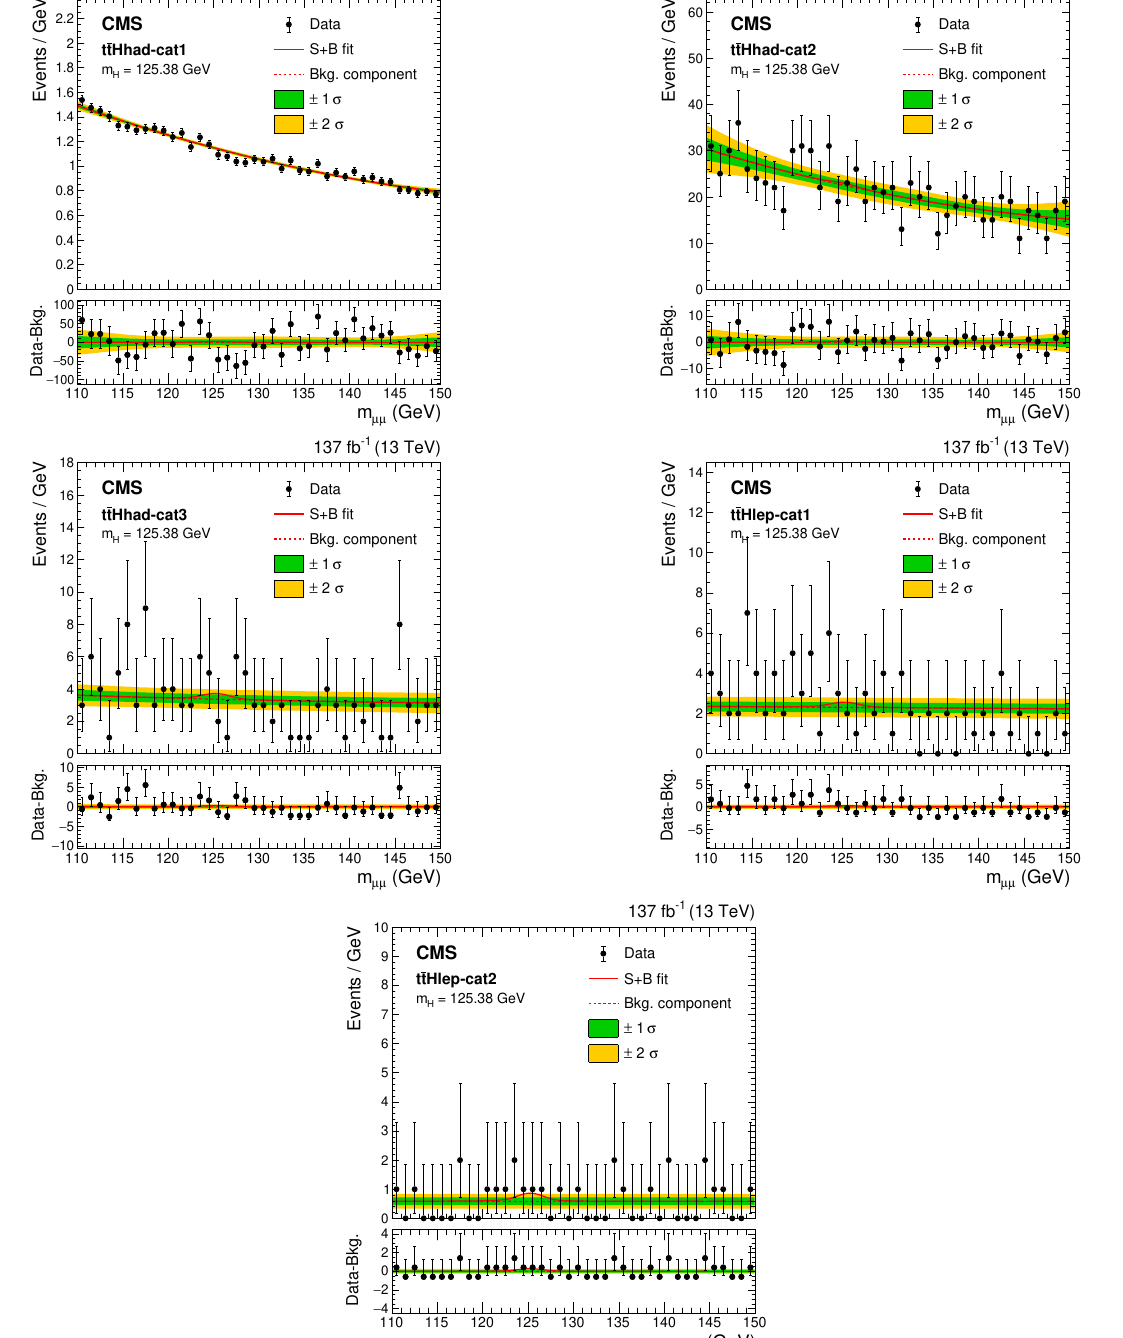
Figure 7 . Comparison between the data and the total background extracted from a S+B fit performed across the various ttH hadronic and leptonic event subcategories. The one (green) and two (yellow) standard deviation bands include the uncertainties in the background component of the fit. The lower panel shows the residuals after the background subtraction, where the red line indicates the signal with m = 125 . 38 GeV extracted from the H